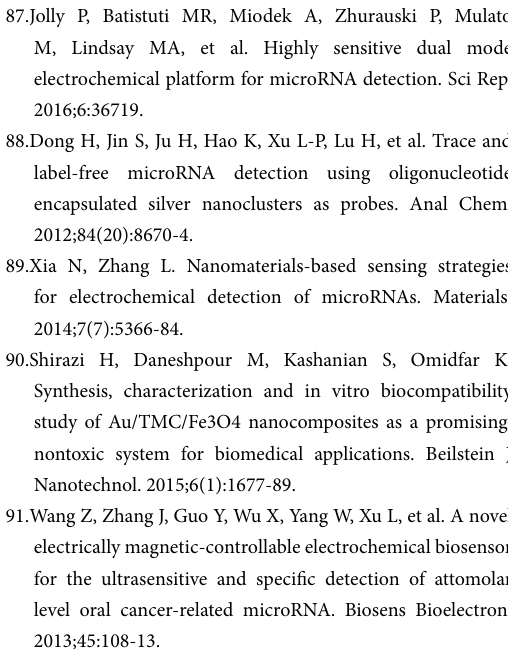
48 Nanomed Res J 2(1): 36-48,